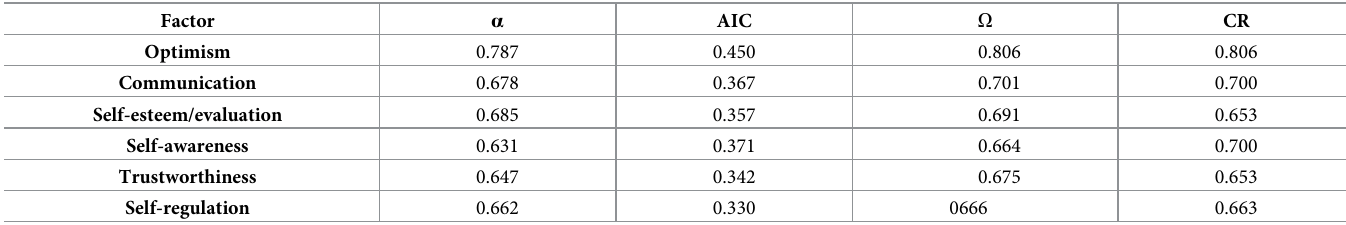
Table 5. Internal consistency and construct reliability of NSARI.